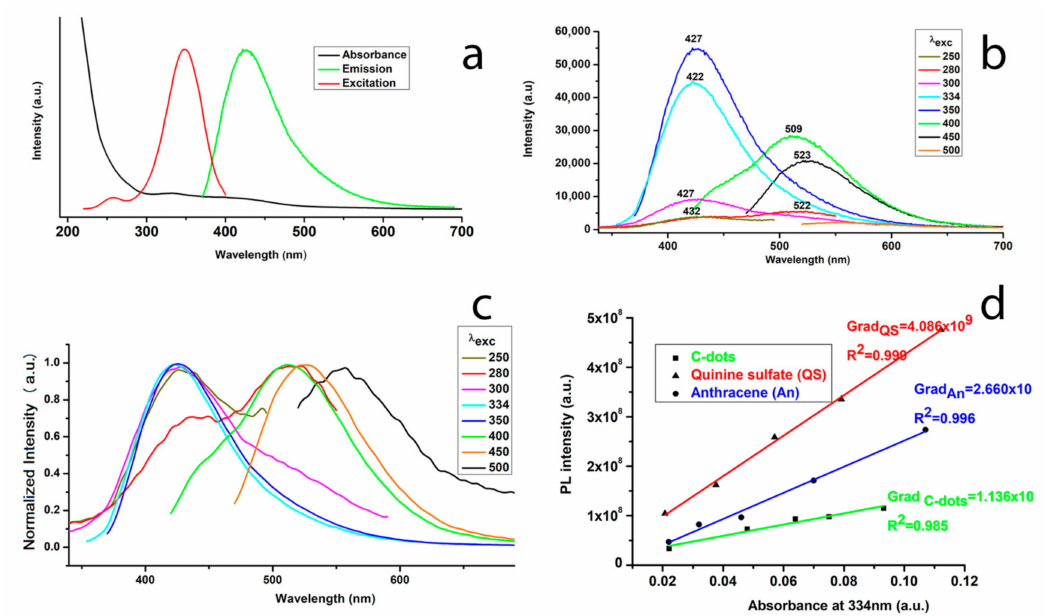
Figure 2. UV–VIS spectra and photoluminescence Excitation (200 nm)—Emission (350 nm) spectra ( a ), photoluminescence spectra ( b , c ) of aqueous C-dots solution; ( d ) fitting used to calculate the quantum yield (QY) of C-dots dispersed in water. The quinine sulfate (QS) and anthracene (An) were used as